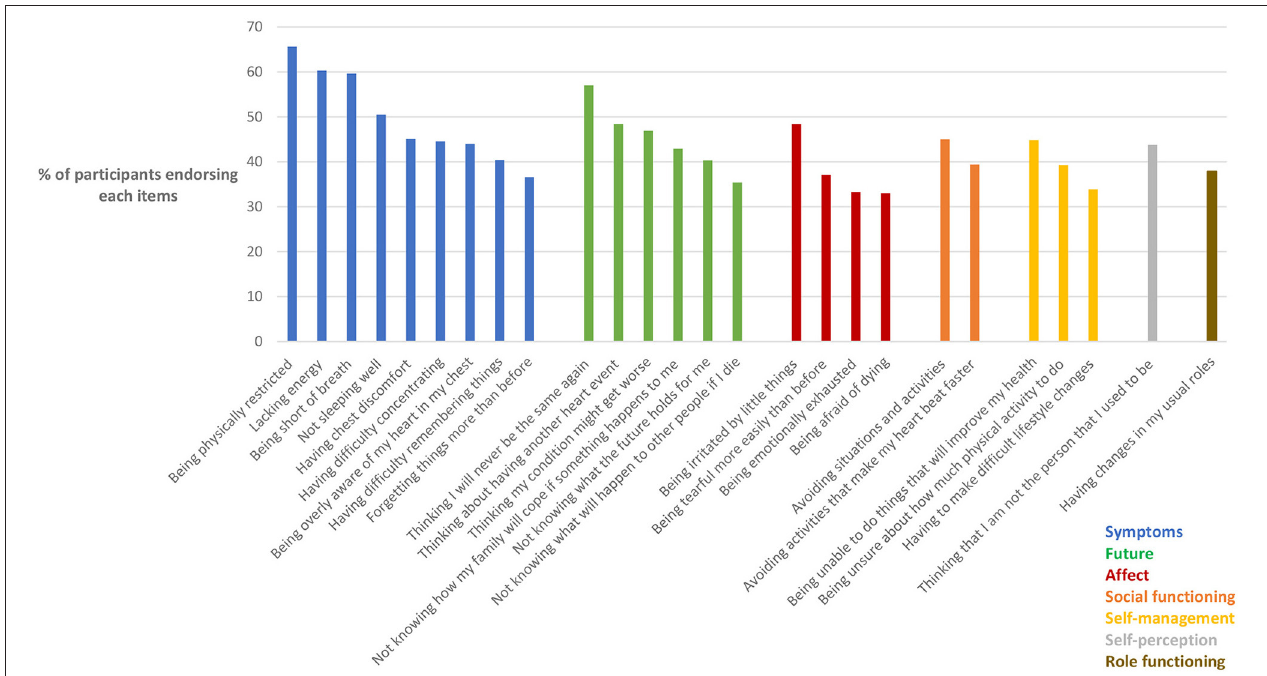
FIGURE 1 | Prevalence of issues and concerns in domains. N = 189–194 with variations due to incompletions in some questionnaires. Only items endorsed by > 33% of participants